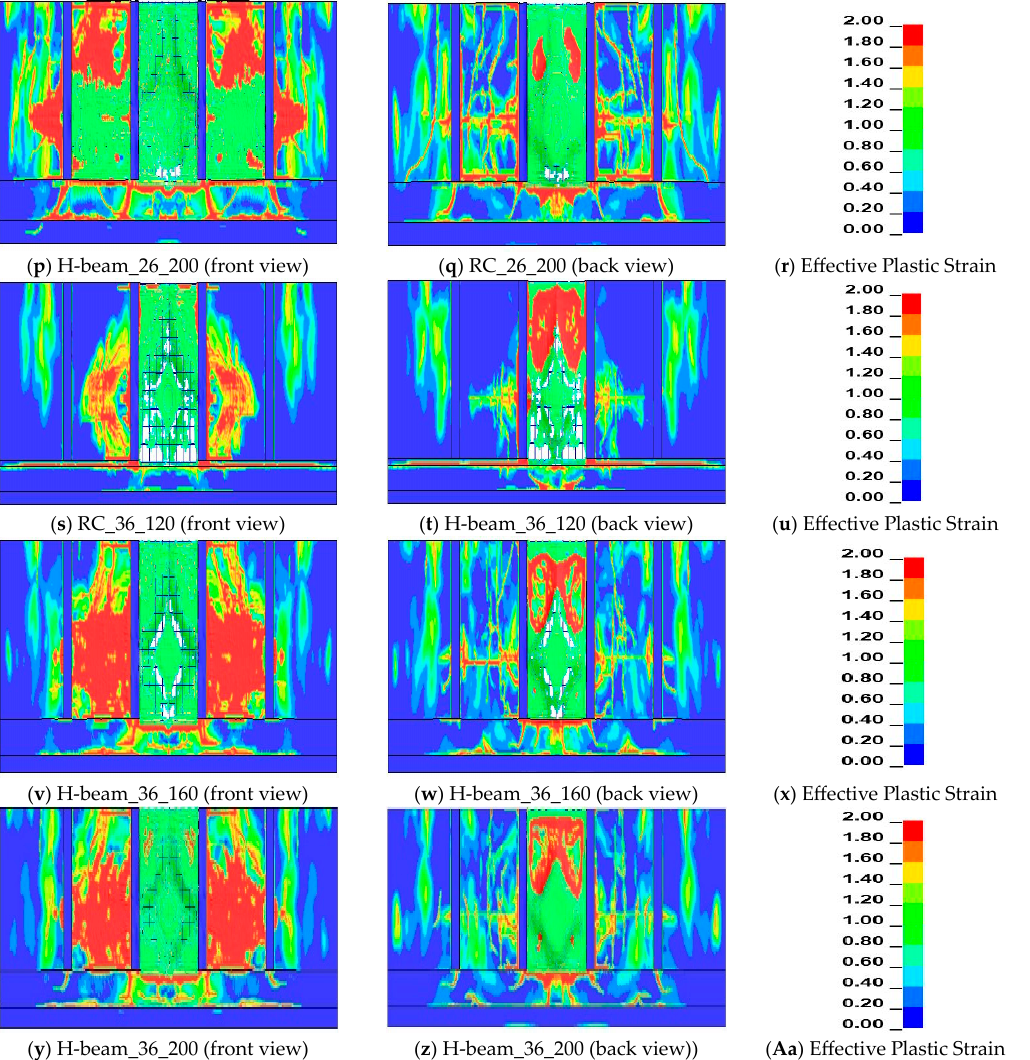
Figure 11. E ff ective plastic strain on composite structure protection wall with di ff erent thickness and stand-o ff distance during Worse Case Scenario. Figure 11. Effective plastic strain on composite structure protection wall with different thickness and stand-off distance during Worse Case